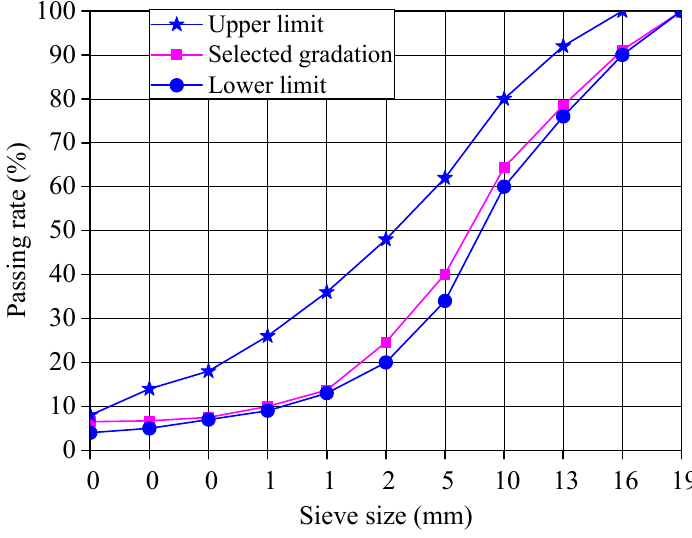
Figure 2. Gradation composition curve of AC-16 asphalt mixture.